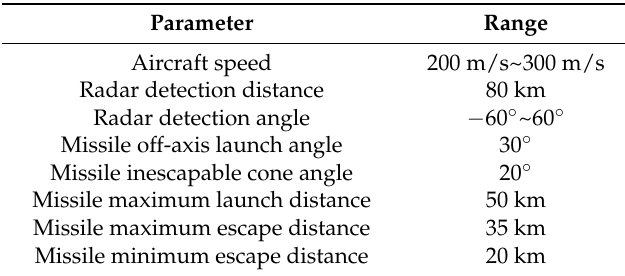
Table 2. Local aircraft performance.